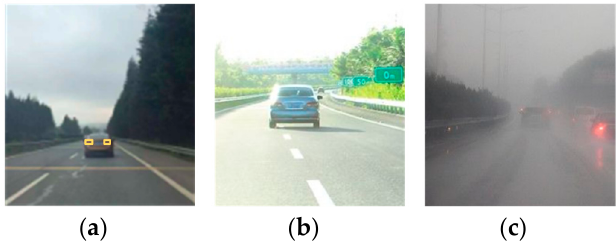
Figure 22. Taillight detection result in different weather conditions. ( a ) The result of correct detection under the normal weather; ( b ) The result of missed detection under the intense illumination; ( c ) The result of the missed detection under the rainy weather. Table 8. Experimental result list.